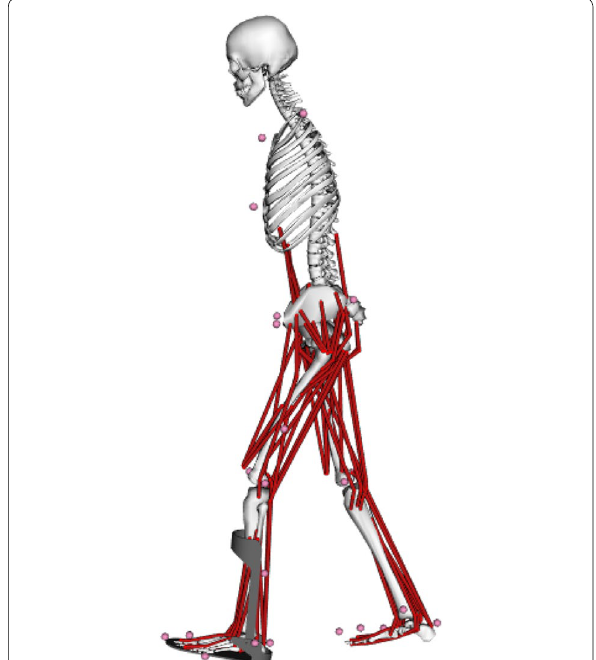
Fig. 2 Musculoskeletal model and ankle foot orthosis model